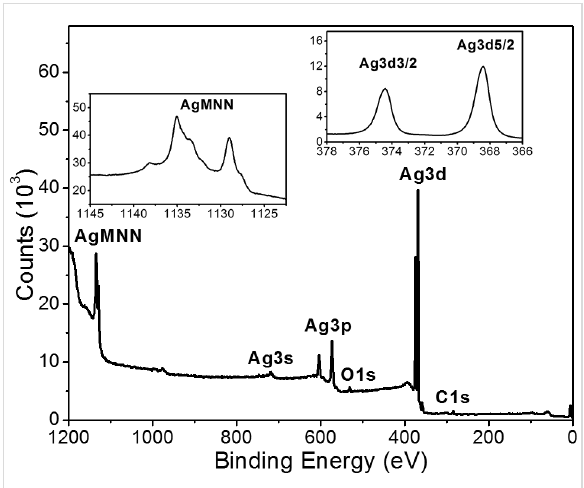
Figure 4: XPS spectra of silver nanoisland films deposited on the Si substrate by laser ablation (PLD) registered in a wide range of binding energy, and Ag 3d and Ag-MNN Auger band registered in a narrow range of energy (insert).